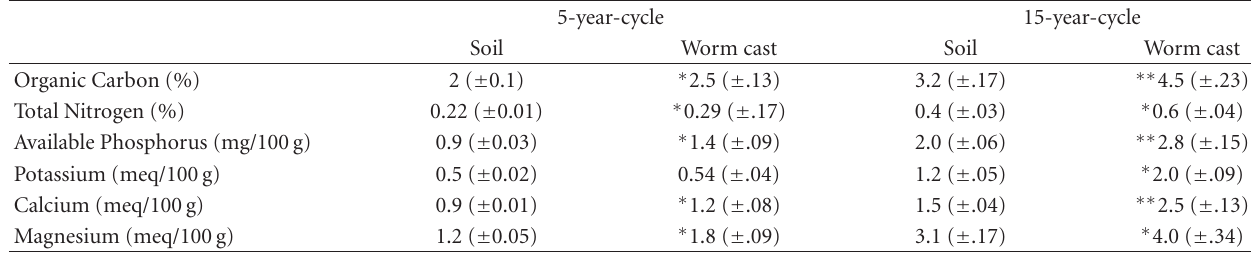
Table 3: Variation in nutrient concentration of earthworm casts and noningested soils during cropping under shifting agriculture in North East India ( ± SE, n = 5) [18].